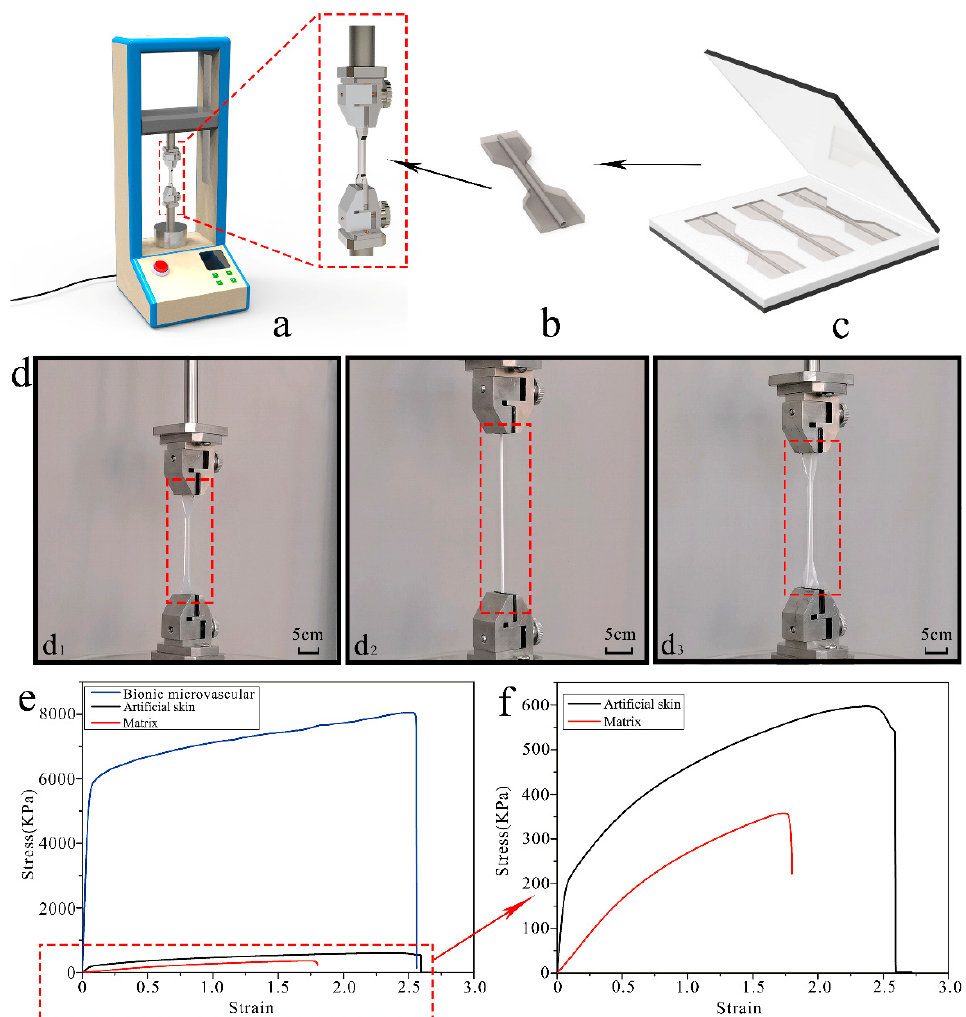
Figure 3. The preparation of artificial skin samples and the mechanical properties of artificial skin. ( a ) Stretching machine for experiments. ( b ) Dumbbell-shaped artificial skin sample. ( c ) The mold for preparing artificial skin samples. ( d ) Comparison of the maximum stretch of a matrix, a bionic microvascular, and artificial skin. ( d1 – d3 ) Matrix, bionic microvascular, and artificial skin. ( e ) The stress–strain curve of a matrix, a bionic microvascular, and artificial skin. ( f ) The stress–strain curve of a matrix and artificial skin.